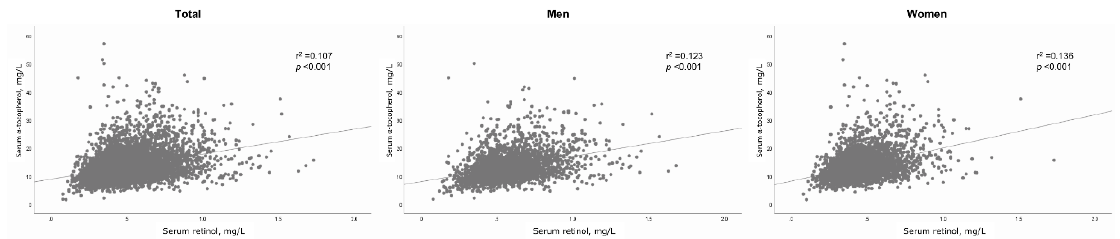
Figure 1. Correlation between serum retinol and α-tocopherol levels. Data are presented as scatter plots with lines of best fit.